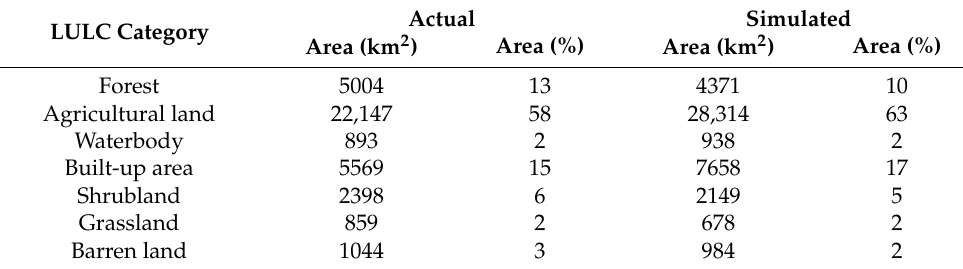
Figure 9. Actual and simulated LULC of 2022. Table 9. Actual and simulated LULC of 2022.